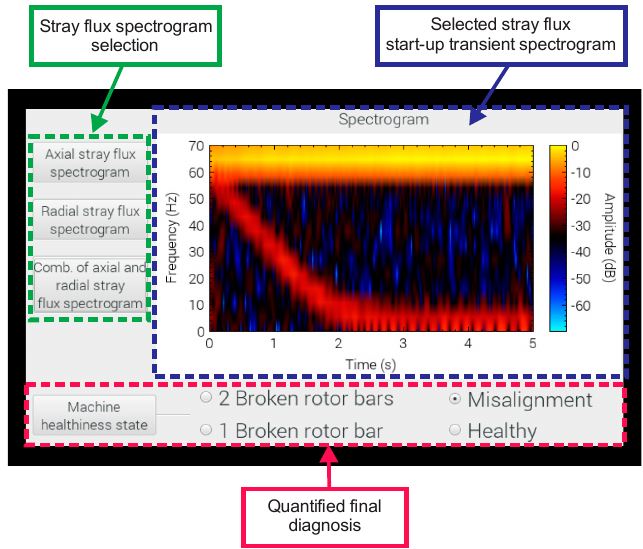
Figure 15. Visualization of the main menu of the smart–sensor.